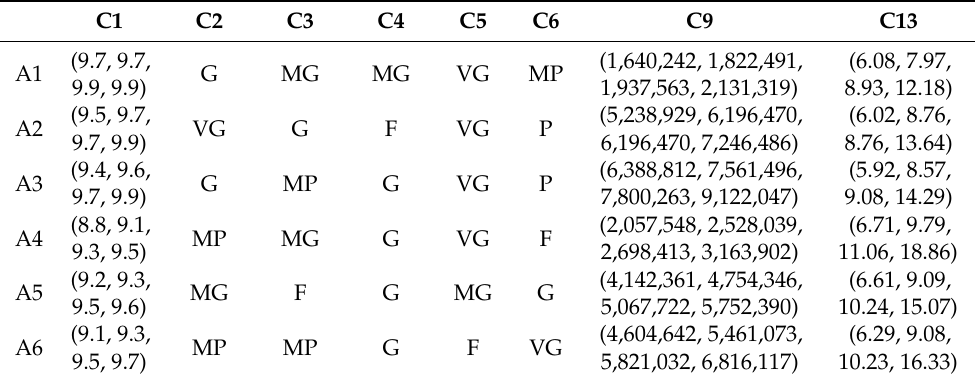
Table 5. Assessments of expert alternatives E 3 .